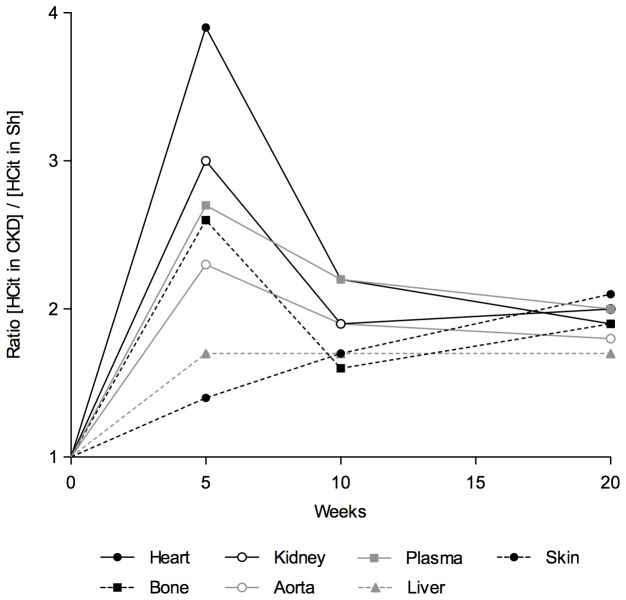
Carbamylated protein accumulation kinetics in plasma and tissues over 20 weeks of CKD.Each point represents the ratio of the mean CP concentration in CKD to that in sham-operated mice (ShSh).